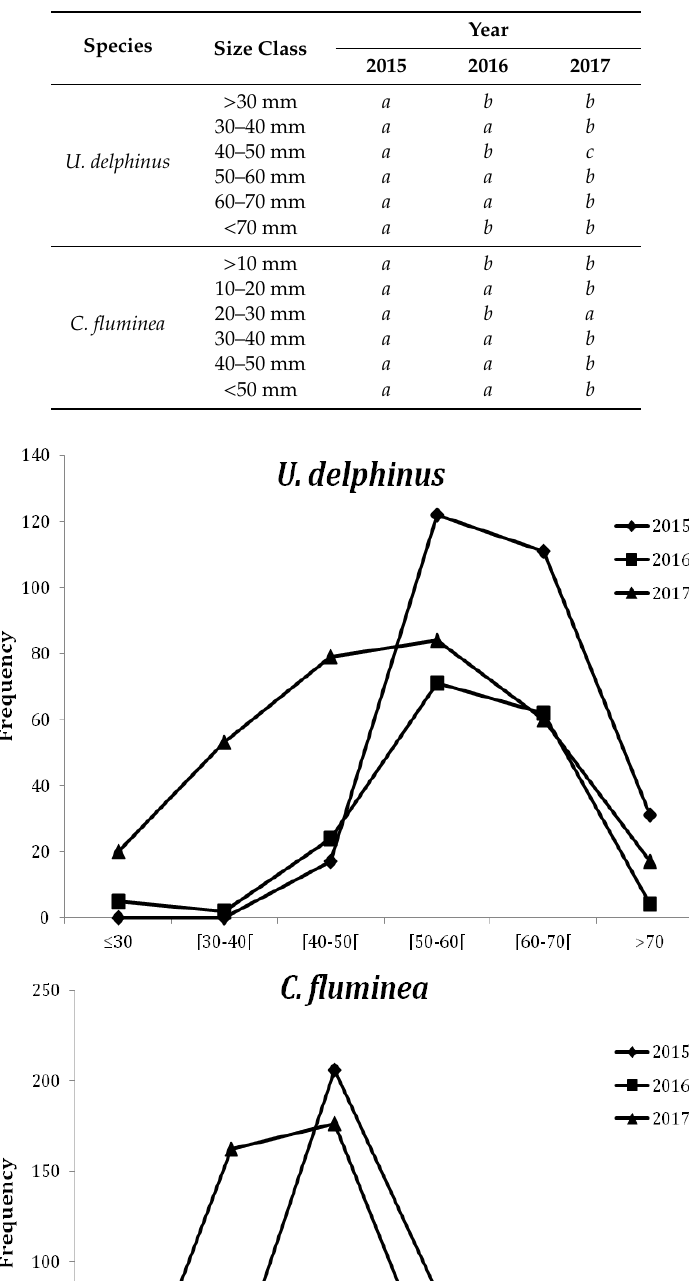
Table 4. Results from the post hoc z test after the G likelihood ratio was performed comparing size structure for both bivalve species. Same letters from a, b and c denote a subset of Year categories whose column proportions do not di ff er significantly from each other at the 0.05 level.